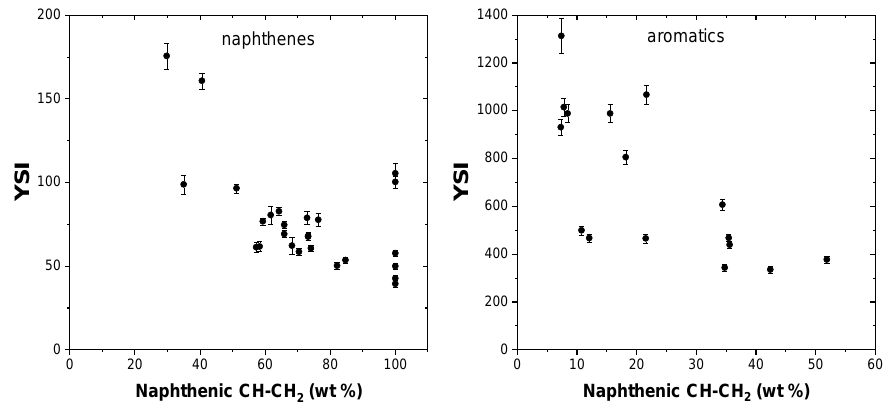
Figure 7. Effect of naphthenic CH-CH 2 groups on YSI .